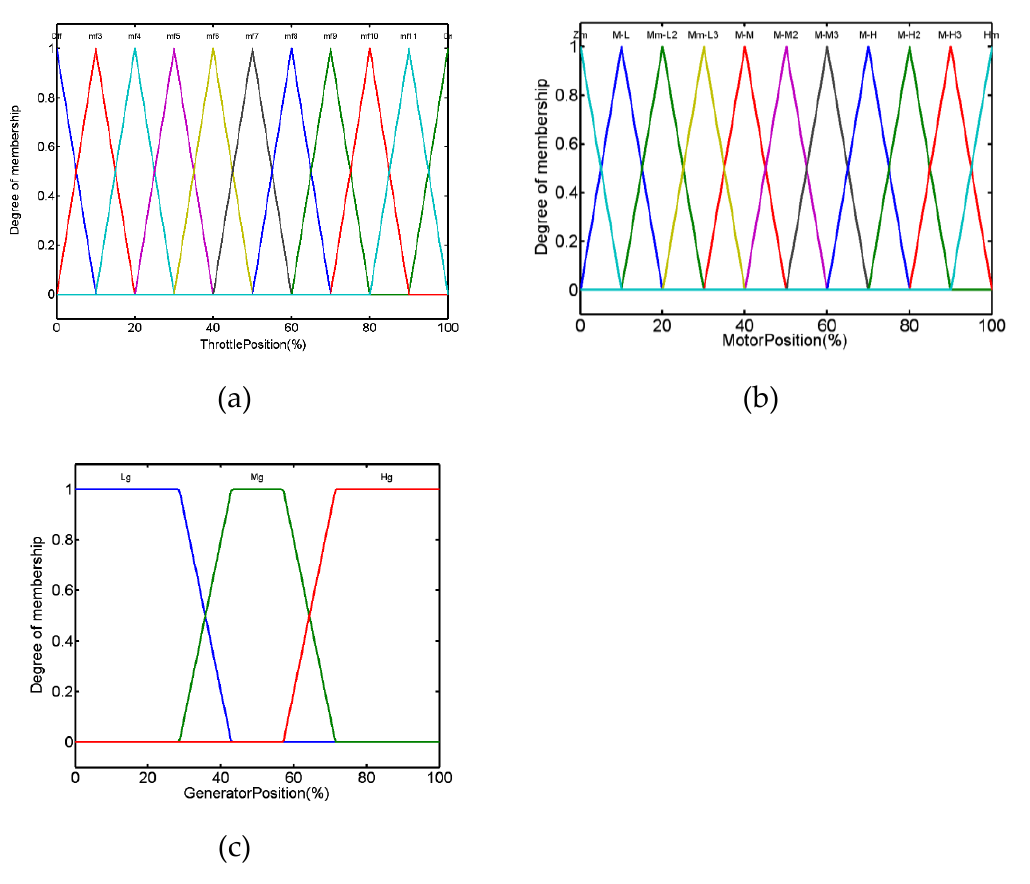
Figure 5. Output attribution functions of ( a ) throttle position, ( b ) motor position, and ( c ) generator position.